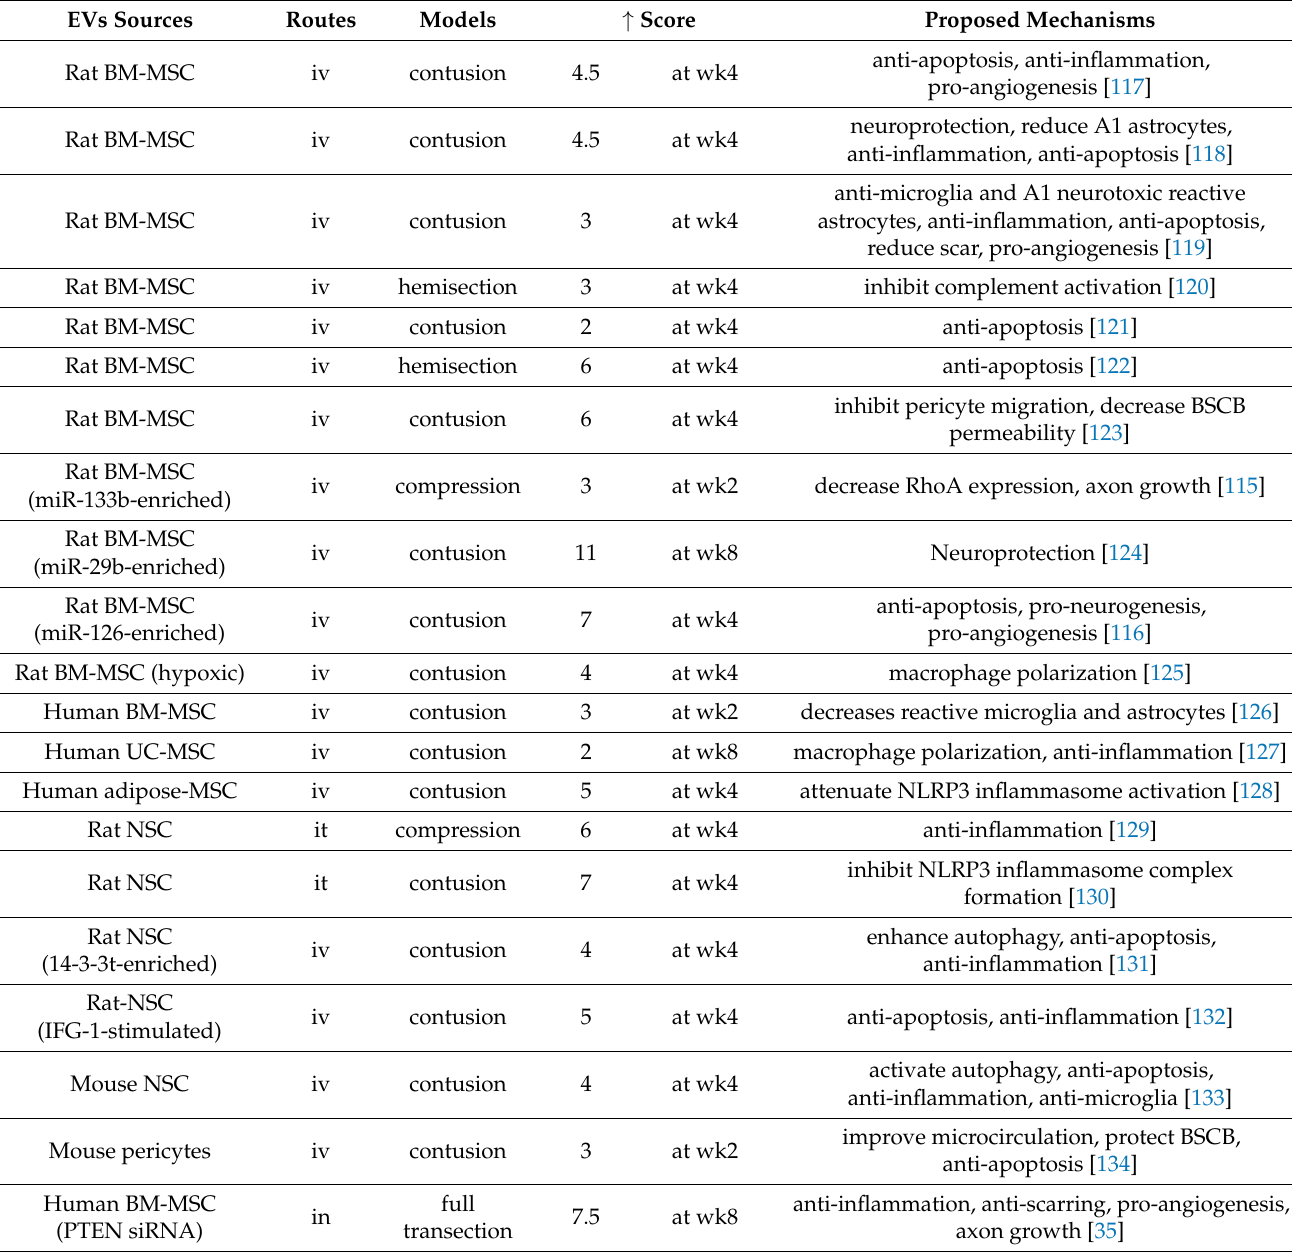
Table 1. List of publications on EVs’ therapeutic effect in SCI. Abbreviations: BM: bone marrow; UC: umbilical cord; MSC: mesenchymal stem/stromal cells; NSC: neural stem cells; iv: intravenous; it: intrathecal; in: intranasal; BSCB: blood–spinal cord barrier. ↑ Score: Increased mean BBB or BMS locomotor score from EVs treatment groups, compared to untreated